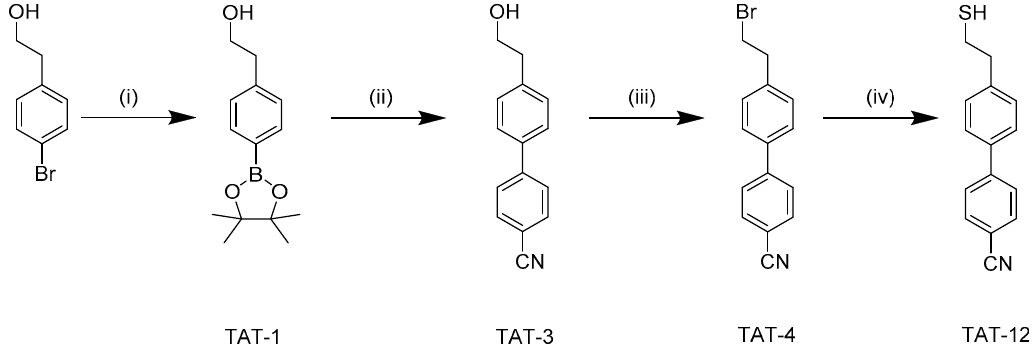
Figure 1. Schematic illustration of synthetic pathway for TAT-12. ( i ) bis(pinacolato)